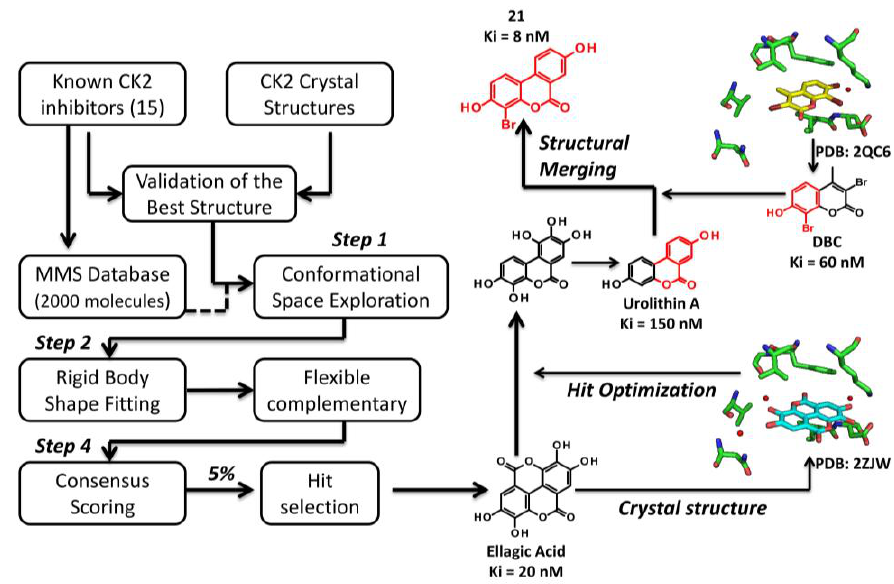
Figure 4. Schematic representation of the structure based virtual screening procedure leading to the discovery of ellagic acid ( left ); on the ( right ) hit optimization of ellagic acid. Inhibition constant (Ki) and PDB (Protein Data Bank) codes have been reported.